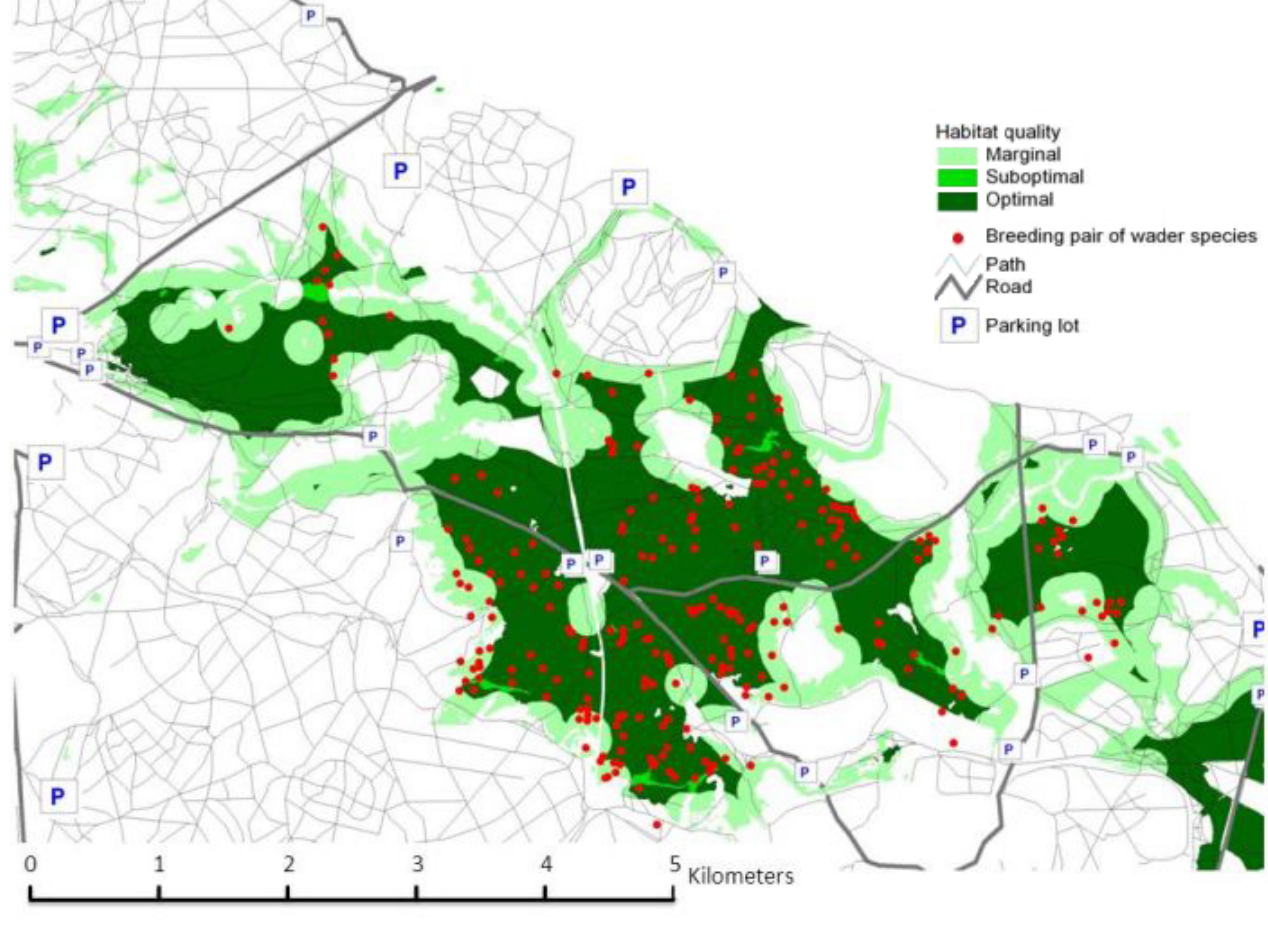
Fig. 3. Map showing the potential habitat for wader species in part of the New Forest. The map used generic knowledge of habitat preferences from the database of the biodiversity tool LARCH (Opdam et al. 2003, Verboom and Pouwels 2004), but was amended by adding local monitoring data and information on landscape features in the New Forest that predicted the current and historic distribution of wader species in this area. Based on local maps consisting of vegetation structure and slope the habitat was classified as optimal, suboptimal, and marginal. In optimal habitat wader species can reach high densities and in marginal habitat low densities. The monitoring data had been gathered over several years and included four wader species: Lapwing ( Vanellus vanellus ), Curlew ( Numenius arquata ), Snipe ( Gallinago gallinago ), and Redshank ( Tringa totanus